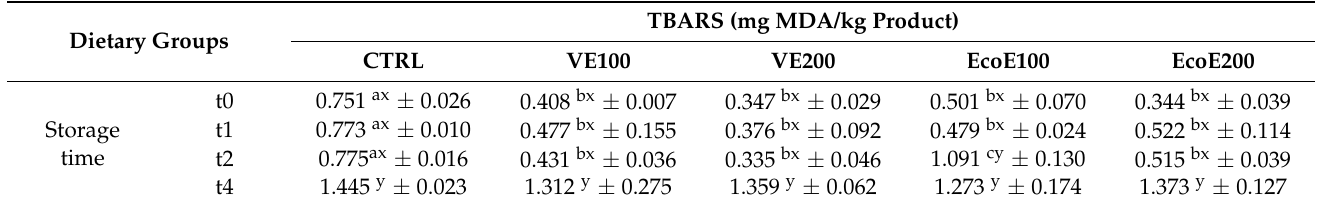
Table 3. The effects of dietary supplementation with α -tocopherol acetate (VE) or EconomasE TM (EcoE) and storage time on the TBARS (mg MDA/kg product) of packaged rabbit hamburgers.